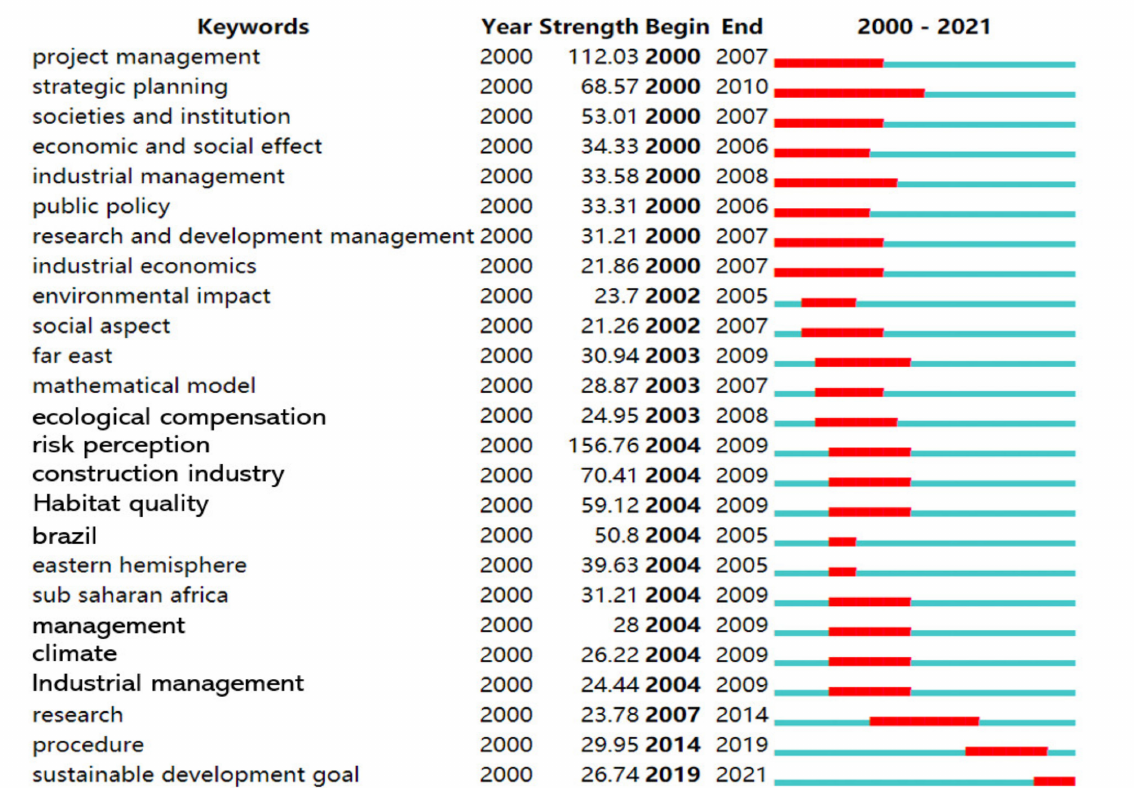
Figure 2. Strongest citation bursts chart analysis of survey statistics (which mainly explain the hot topics studied in the concentrated time